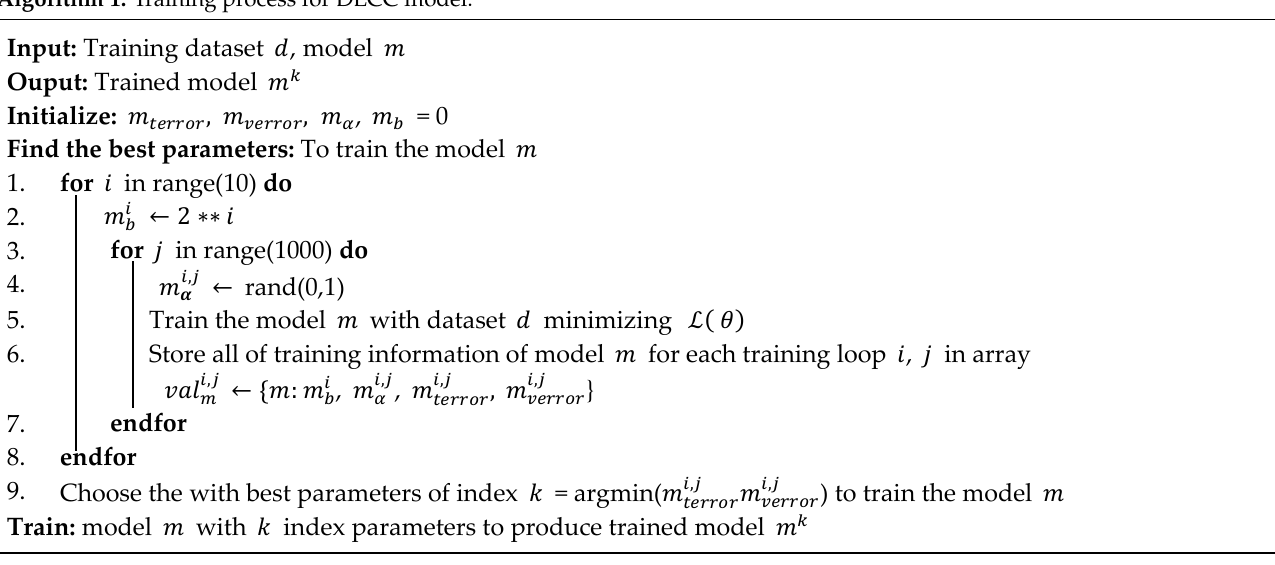
Algorithm 1: Training process for DLCC model.